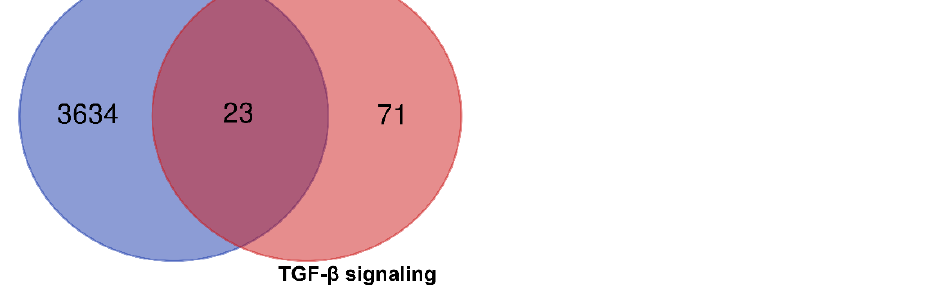
Figure 2. Schematic view of the GSE4290 dataset result after analyzing with GEO2R for the most common genes involved in glioblastoma. It was found that 23 genes are contributed to glioblas- toma progression.